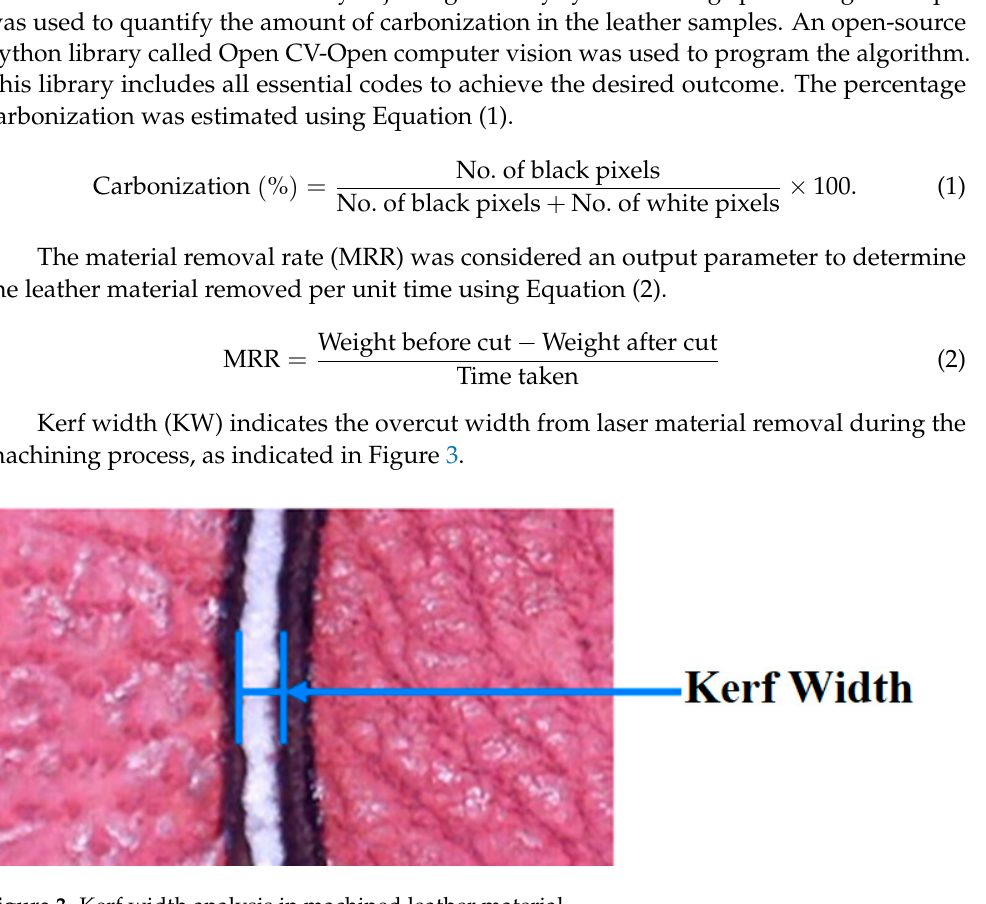
Figure 3. Kerf width analysis in machined leather material.